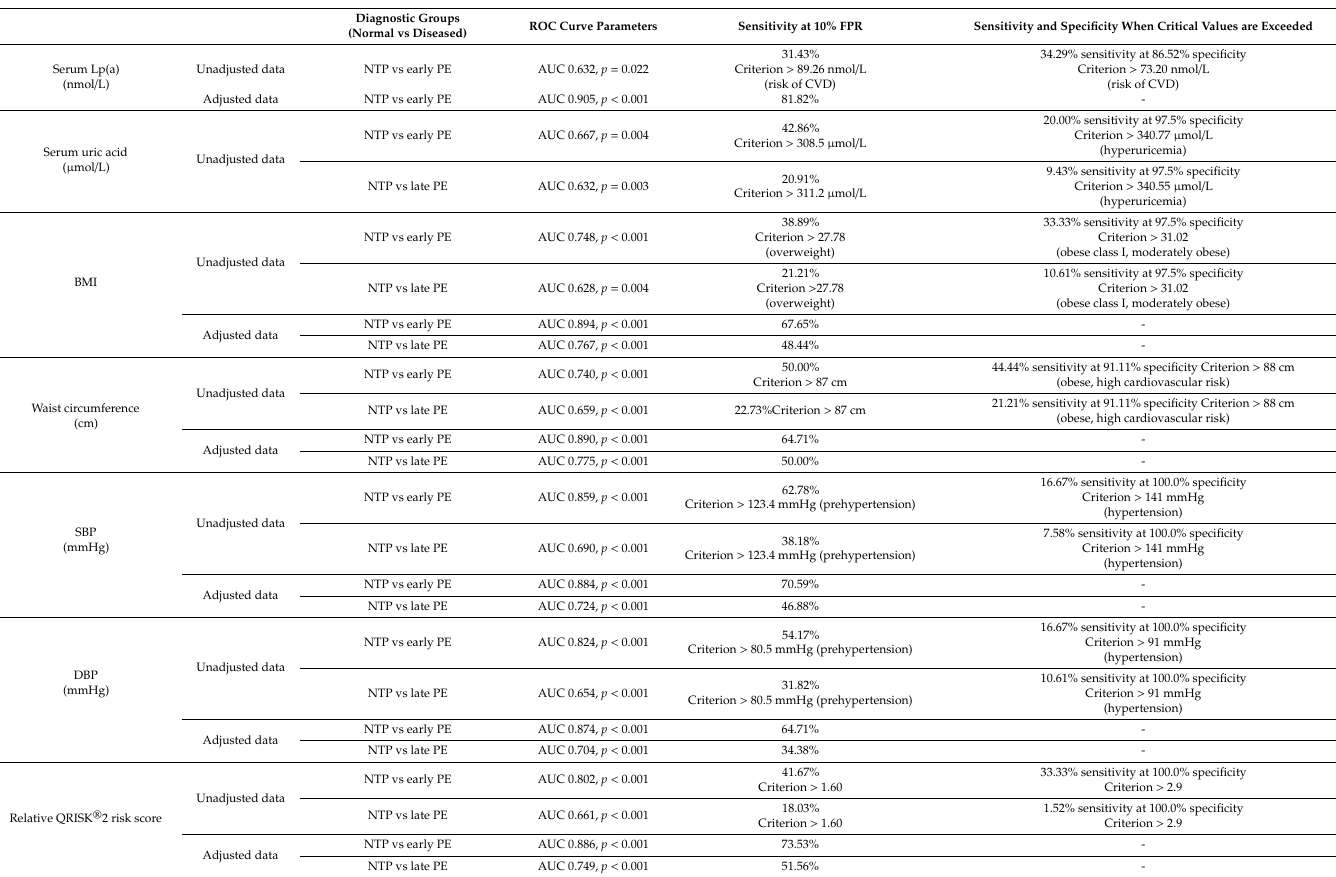
The unadjusted and adjusted receivers operating characteristic (ROC) curves were constructed to calculate the area under the curve (AUC) and the best cut-o ff points for particular studied parameters or biomarkers were used in order to calculate the respective sensitivity at 90.0% specificity (MedCalc, version 16.8.4, MedCalc Software bvba, Ostend, Belgium). We also reported for unadjusted data the information showing the sensitivity at criterions exceeding the critical values (number of cases exceeding the critical values). Data were adjusted for potential covariates, where appropriate, including current maternal age, BMI, parity, the time after the birth (in months), the oral contraceptive use status (ex-user, current user, non-user), the smoking status (ex-smoker, smoker, non-smoker), the average values of systolic and diastolic blood pressures, and hypertension on the treatment (yes, no). The significance level was established at p -value of p < 0.05. PE, preeclampsia; NTP, normotensive term pregnancies; Lp(a), lipoprotein a; BMI, body mass index; SBP, systolic blood pressure; DBP, diastolic blood pressure; AUC, area under curve; FPR, false positive